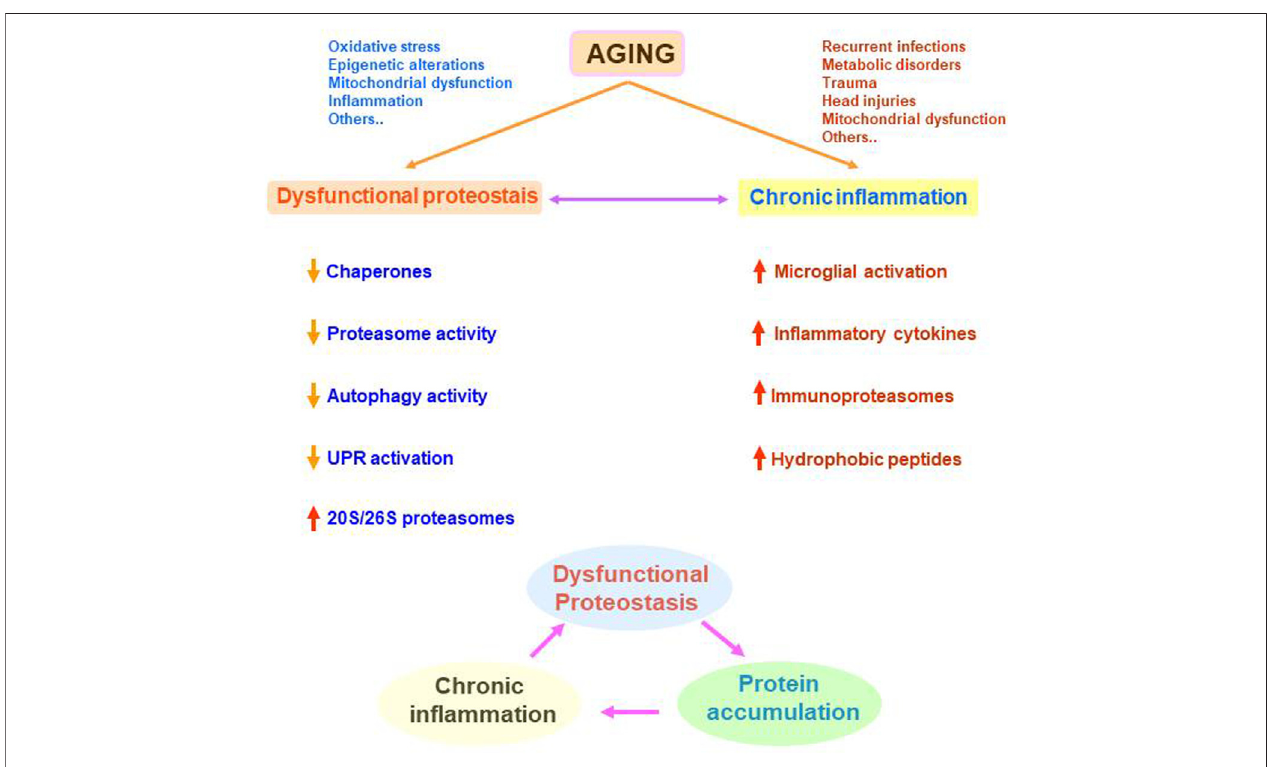
FIGURE 4 | Representation of the age-related alterations in cellular proteostasis and in fl ammation and their potential synergistic negative effects. Many different situations occurring all along the life can be involved in dysfunctional proteostasis and/or chronic in fl ammation. These two processes can be modulating each other leading to a vicious circle. Dysfunctional proteostasis leads to protein accumulation that can potentiate or sustains chronic in fl ammation. In turn, chronic in fl ammation potentiates dysfunctional